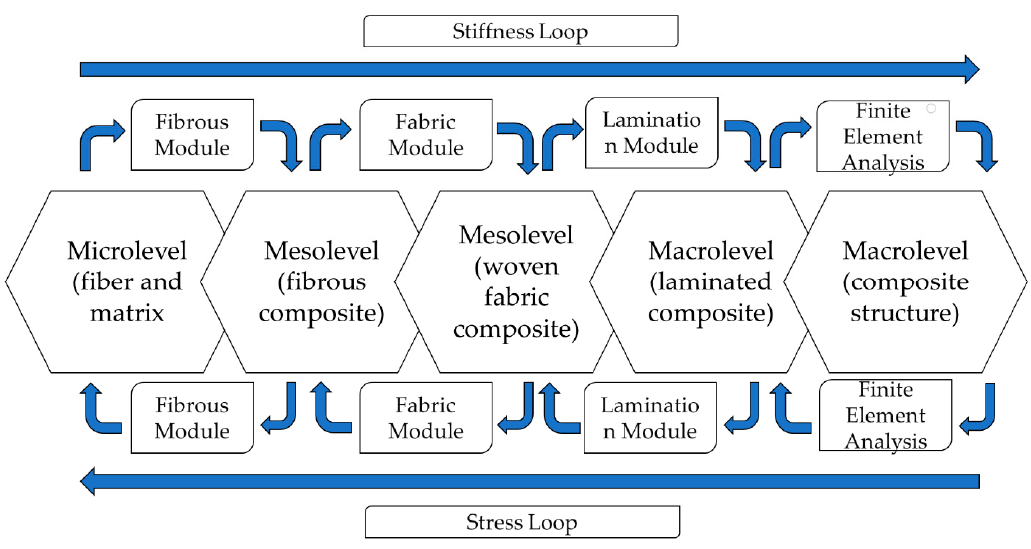
Figure 7. Multiscale analysis hierarchy for a two-way fiber reinforced composite.